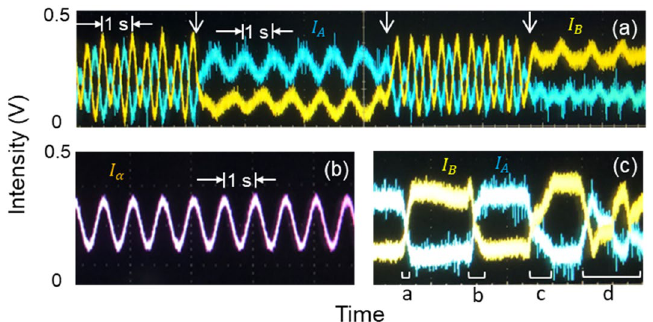
Figure 3. Experimental results for USCKD in Fig. 1. ( a ) ψ 12 (c) expansion of ( b ). ( d ) Conventional MZI output (green) vs. CBW [USCKD(a/b/c)] (red). In ( b ) and ( c ), 1 Hz before the dashed line; ϕ 12 ϕ 12 ψ 12 = − = arbitrary.